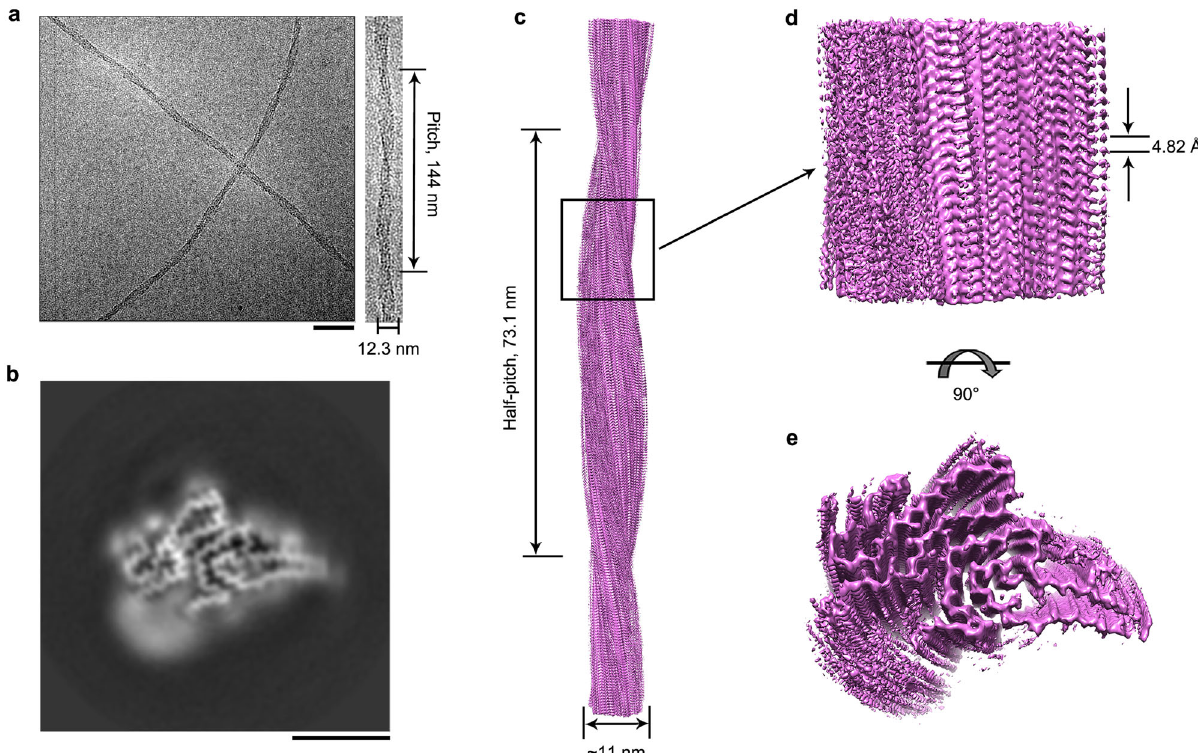
Fig. 1 Cryo-EM structure of SOD1 fi bril. a Raw cryo-EM image of amyloid fi brils assembled from recombinant, full-length apo human SOD1 under reducing conditions. Enlarged section of a (right) showing a single proto fi lament intertwined into a left-handed helix, with a fi bril full width of 12.3 ± 0.7 nm and a helical pitch of 144 ± 5 nm. The scale bar represents 50 nm. The helical pitch and fi bril width were measured and expressed as the mean ± SD of values obtained in n = 8 biologically independent measurements. Source data are provided as a Source Data fi le. b Cross-sectional view of the 3D map of the SOD1 fi bril showing a proto fi lament comprising the N-terminal part (left) and the C-terminal part (right), with an unstructured fl exible region (bottom). Scale bars, 5 nm. c 3D map showing a single proto fi lament (in orchid) intertwined into a left-handed helix, with a fi bril core width of ~11 nm and a half- helical pitch of 73.1 nm. d Enlarged section showing a side view of the density map. Close-up view of the density map in c showing that the subunit in proto fi lament stacks along the fi bril axis with a helical rise of 4.82 Å. e Top view of the density